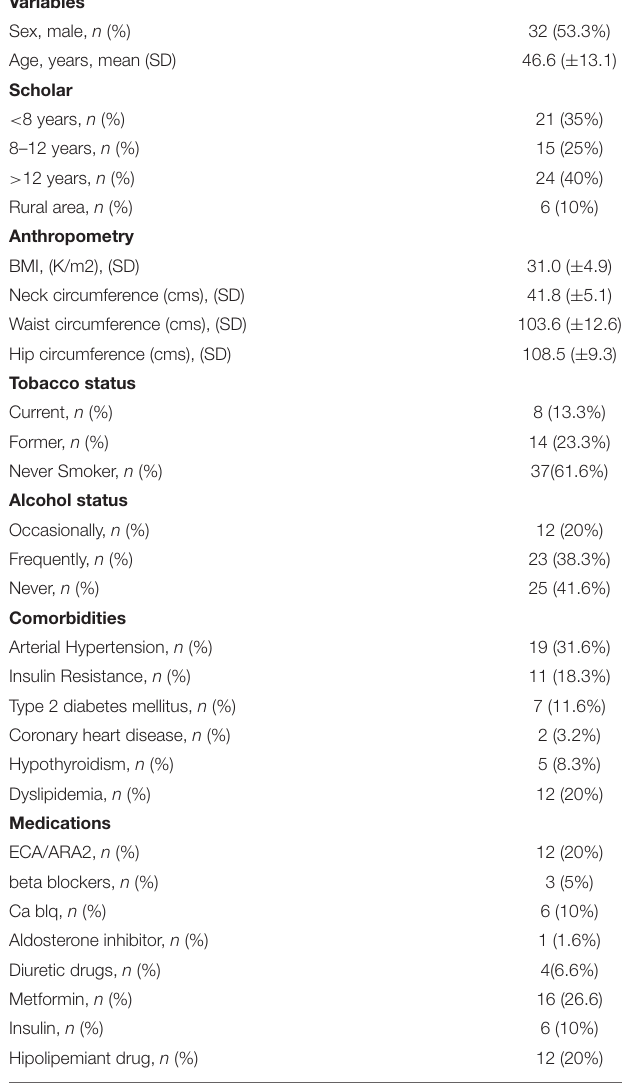
TABLE 1 | Baseline characteristics of the complete cohort ( n = 60). TABLE 2 | Respiratory sleep study test of the complete cohort ( n = 60).